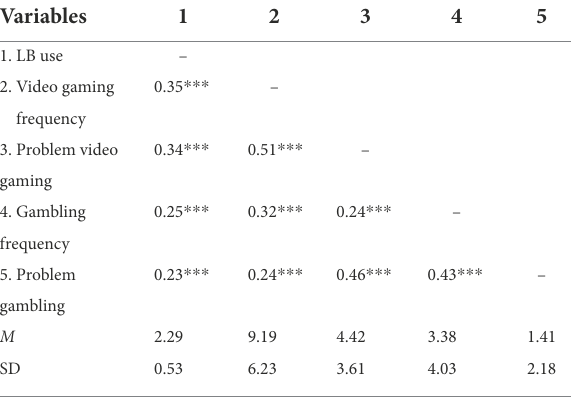
TABLE 3 Means, standard deviations, and correlations among LB use, video gaming frequency, problem video gaming, gambling frequency, and problem gambling, in Study